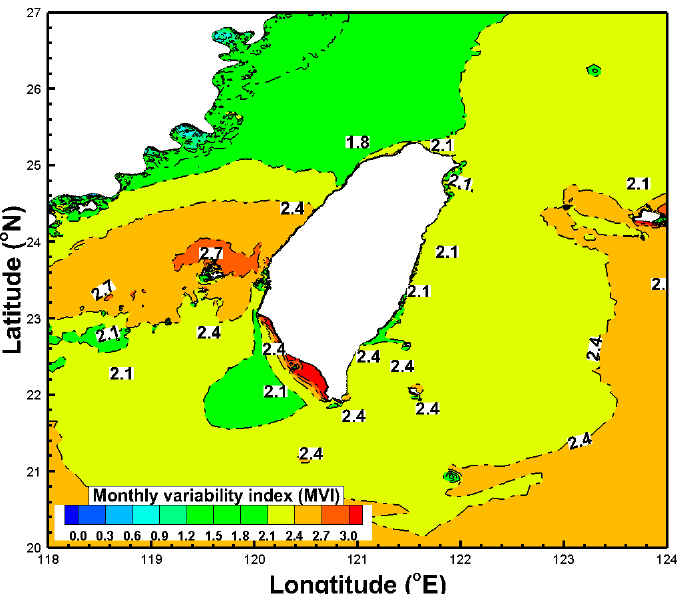
Figure 13. Spatial distribution of the monthly variability index (MVI) of wave power in the offshore waters of Taiwan averaged over 1991 to 2010.